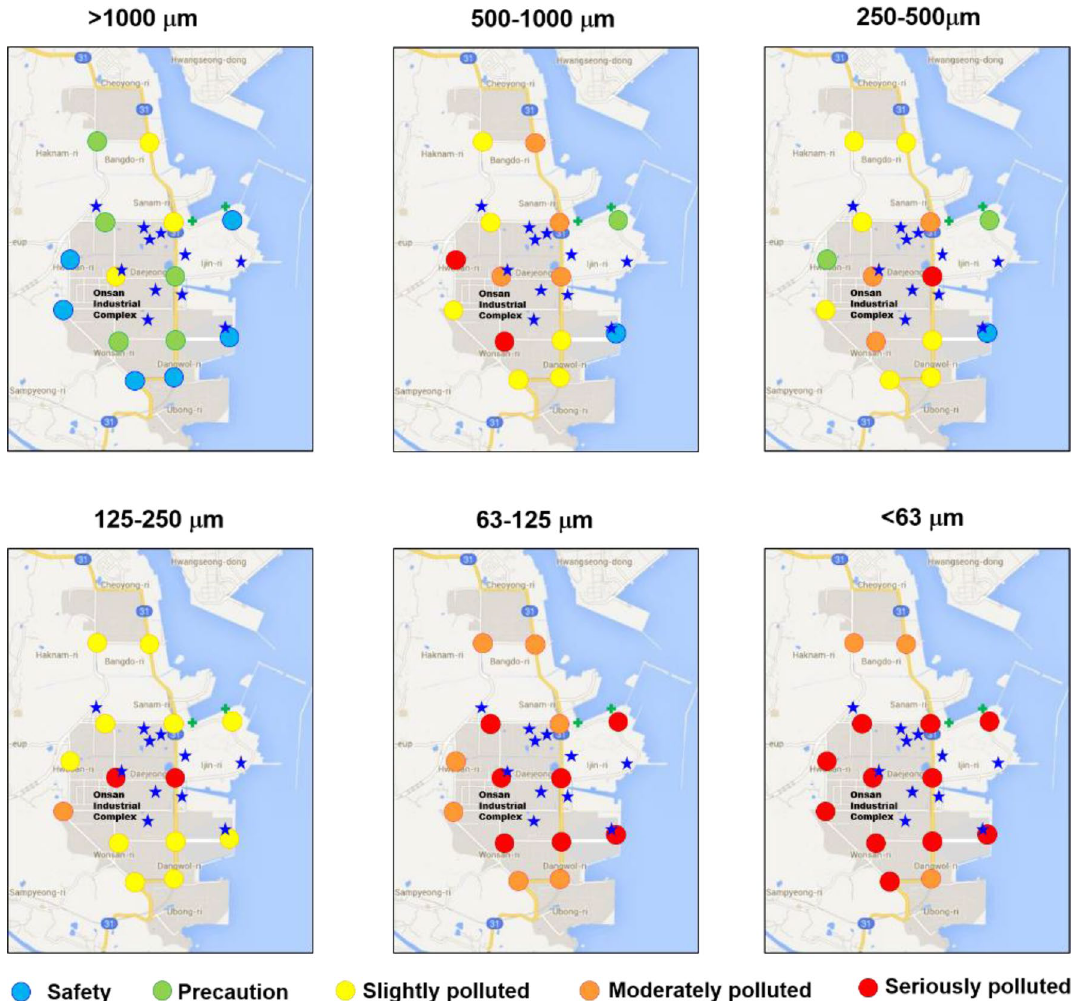
Figure 4. Spatial distribution of nemerow index (P N ) values in the different sizes of road deposited sediments. Blue star symbol means a smelting facility. Figure created using Microsoft Office PowerPoint 2016 based on Google Maps (available at https:// www. google. com/ maps).